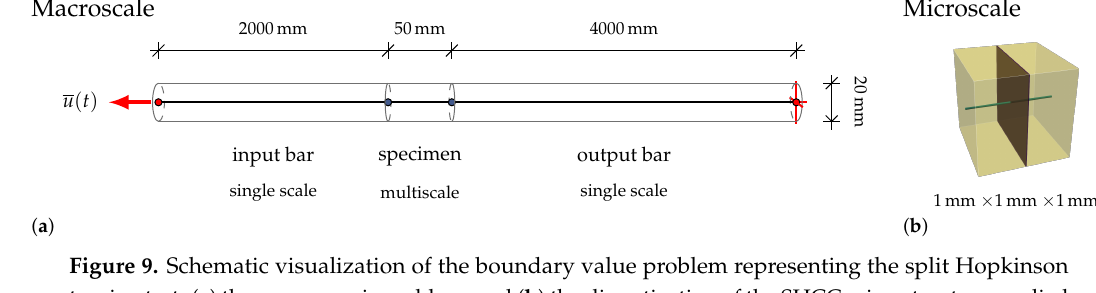
Figure 9. Schematic visualization of the boundary value problem representing the split Hopkinson tension test: ( a ) the macroscopic problem; and ( b ) the discretization of the SHCC microstructure applied in the multiscale simulation of the test